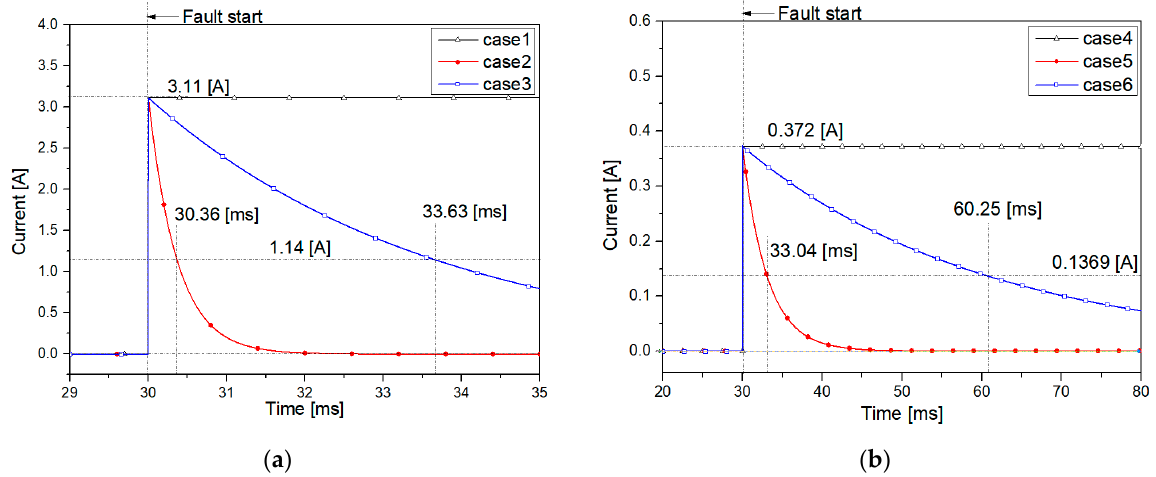
Figure 12. Fault current for a fault resistance of 10 Ω ( a ) Resistance used in mid ‐ point ground was 100 Ω ; ( b ) Resistance used in mid ‐ point ground was 1000 Ω . 100 Ω ; ( b ) Resistance used in mid-point ground was 1000 Ω